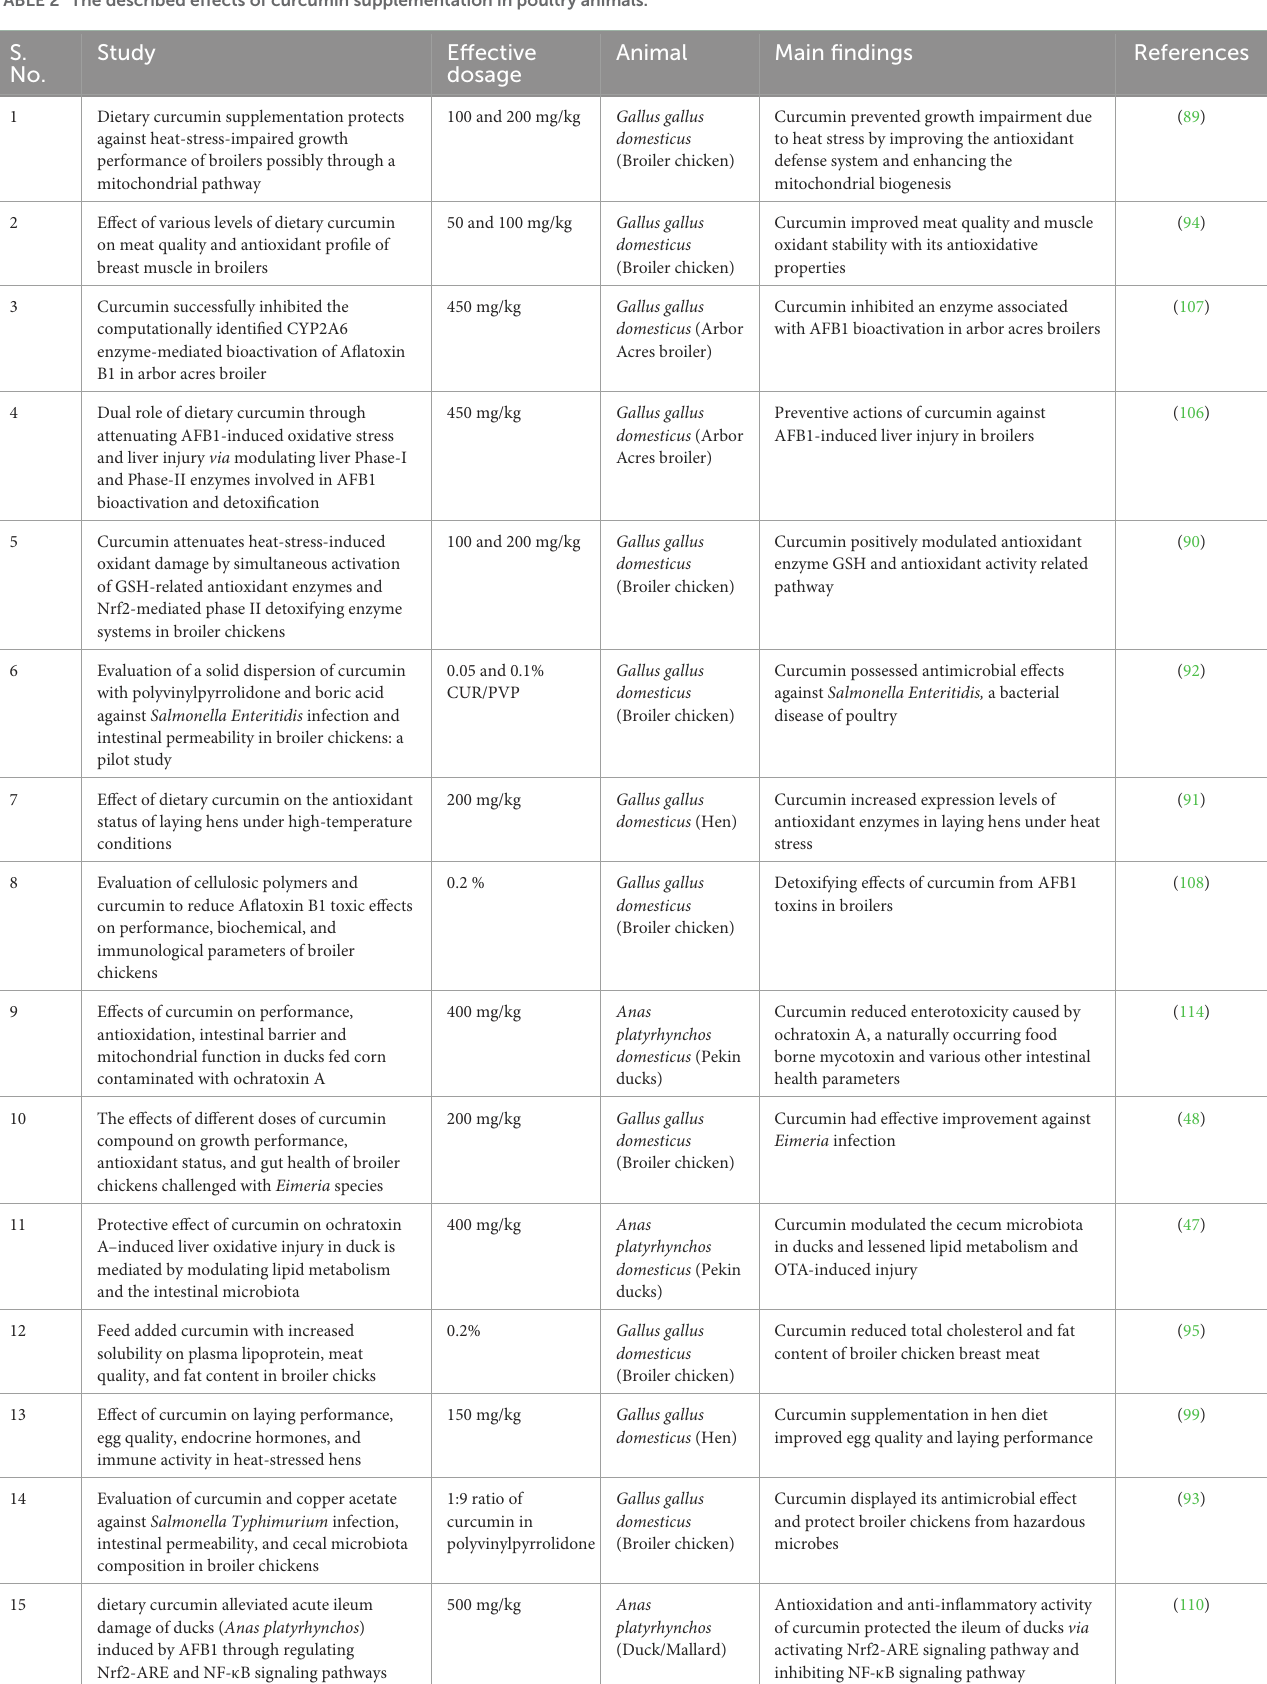
TABLE 2 The described effects of curcumin supplementation in poultry animals. S.